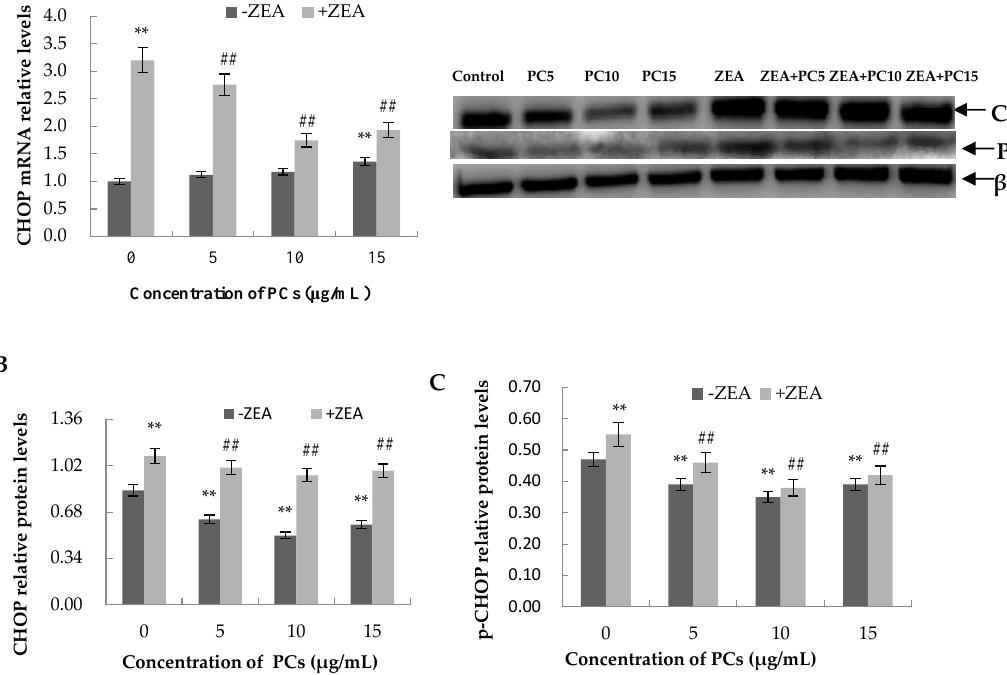
Figure 16. Effects of different concentrations of proanthocyanidins (PCs) on zearalenone (ZEA)-induced relative expression of mRNA and C/EBP homologous protein (CHOP) protein ( A , B ) in MODE-K cells and the relative expression of p-CHOP protein ( C ). When the concentration of PCs was 10 µ g/mL, PCs could significantly decrease the increase in expressions induced by ZEA. ** p < 0.01 vs. control group; # # p < 0.01 vs. ZEA-treated group.